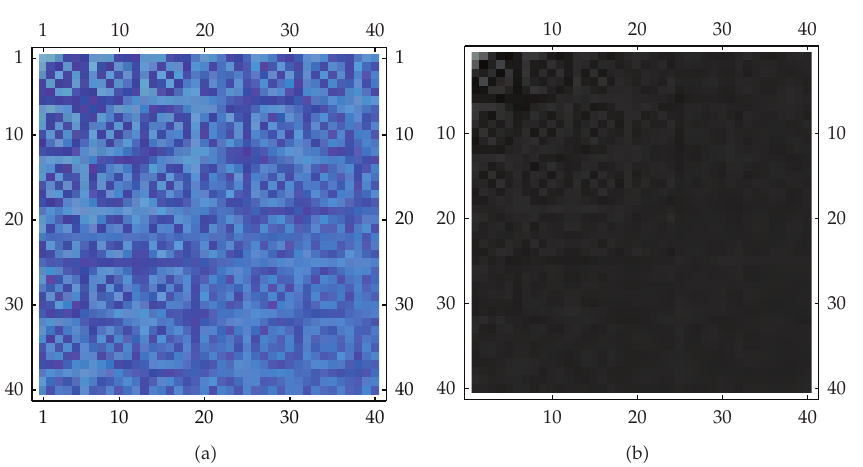
Figure 2: The matrix plot (cid:4) a (cid:5) and the array plot (cid:4) b (cid:5) of the coe ffi cient complex matrix in test problem 2. Table 2: Results of comparisons for the test problem 2 with condition number 18137.2. Iterative